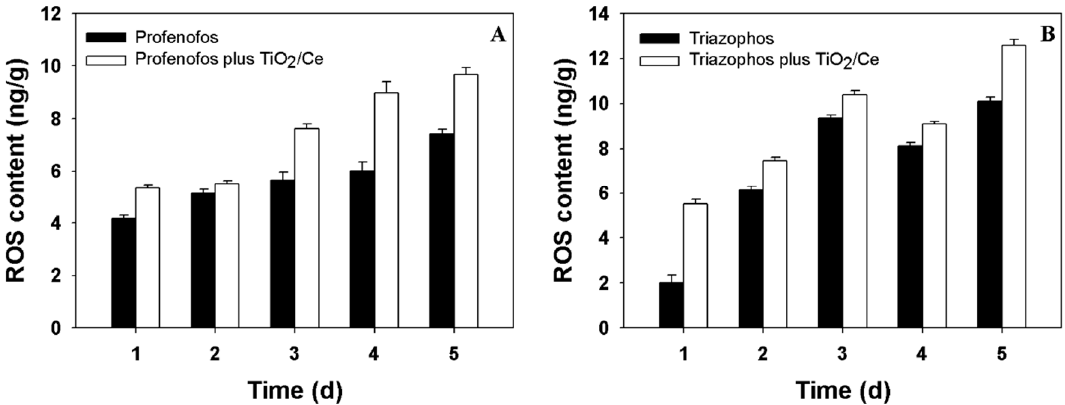
Figure 2. ROS content in B. chinensis treated with/without TiO 2 /Ce. ( A ) profenofos; ( B ) triazophos.